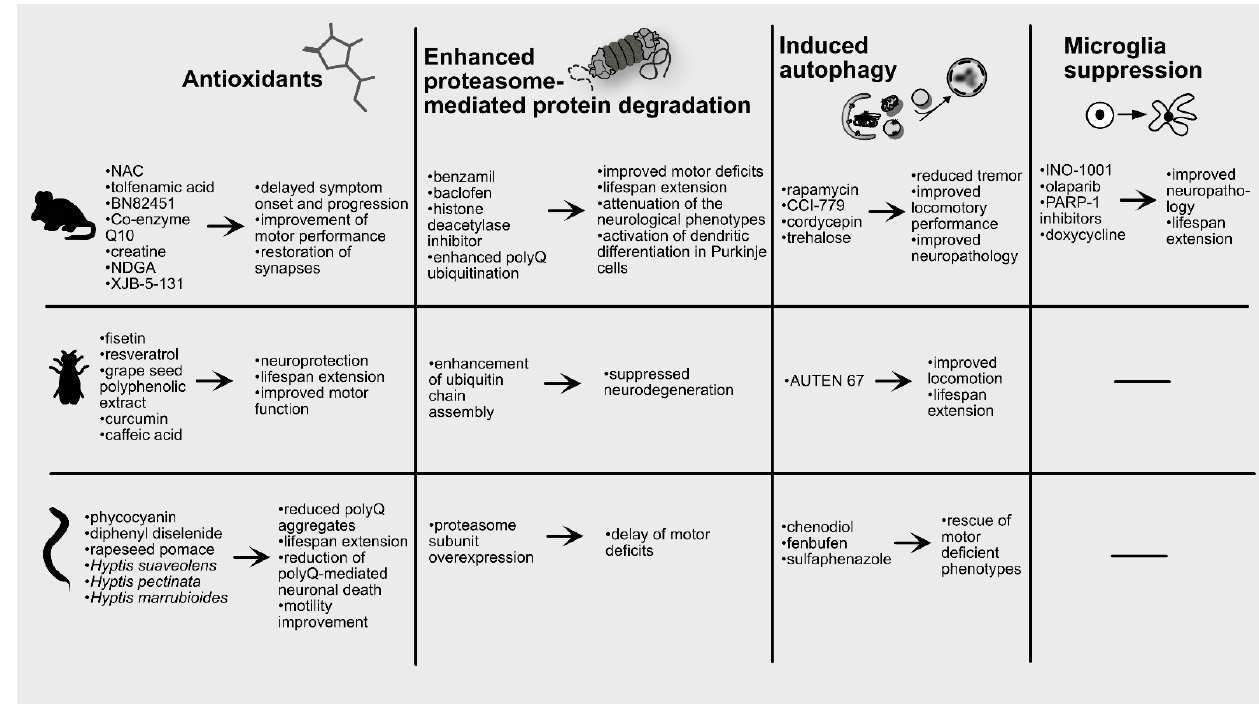
Figure 3. Effects of antioxidants and UPS, autophagy, microglia modulation in polyQ animal models. Various antioxidants were repeatedly shown to exert neuroprotective effects in mouse, Drosophila and C. elegans polyQ models. Similarly, genetic or compound-mediated enhancement of UPS components and autophagy results in attenuation of the symptom manifestation and/or improvement of the animal physiology. Finally, microglia suppression was found to be beneficial in mouse polyQ models.